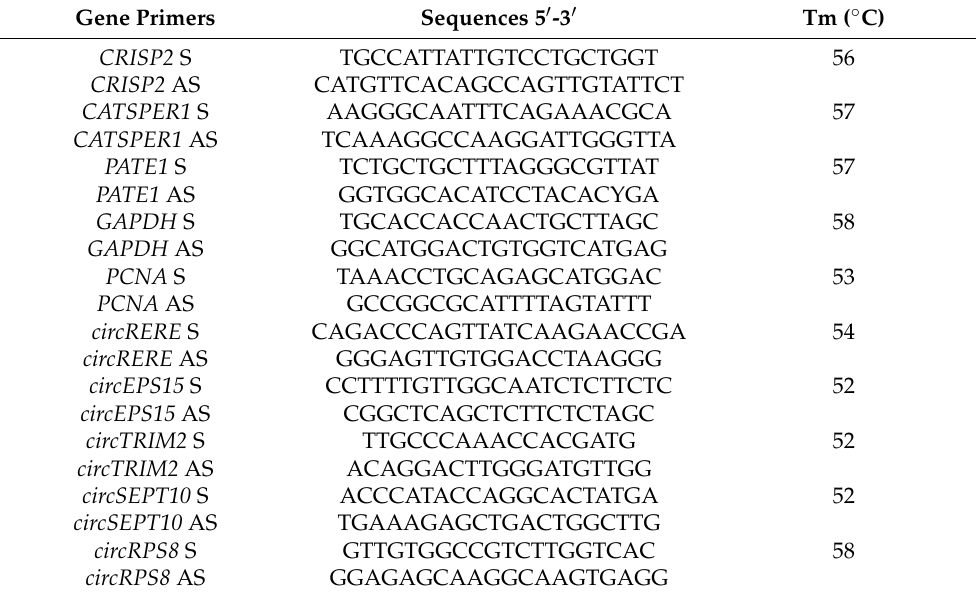
Table 1. Primer Sequence and Annealing Temperature for mRNAs and